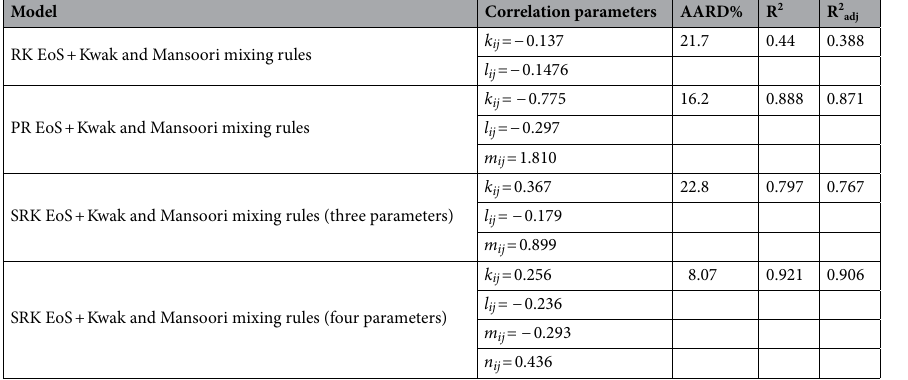
Table 7. Calculated results for the Cubic EoS + Kwak and Mansoori mixing rules.